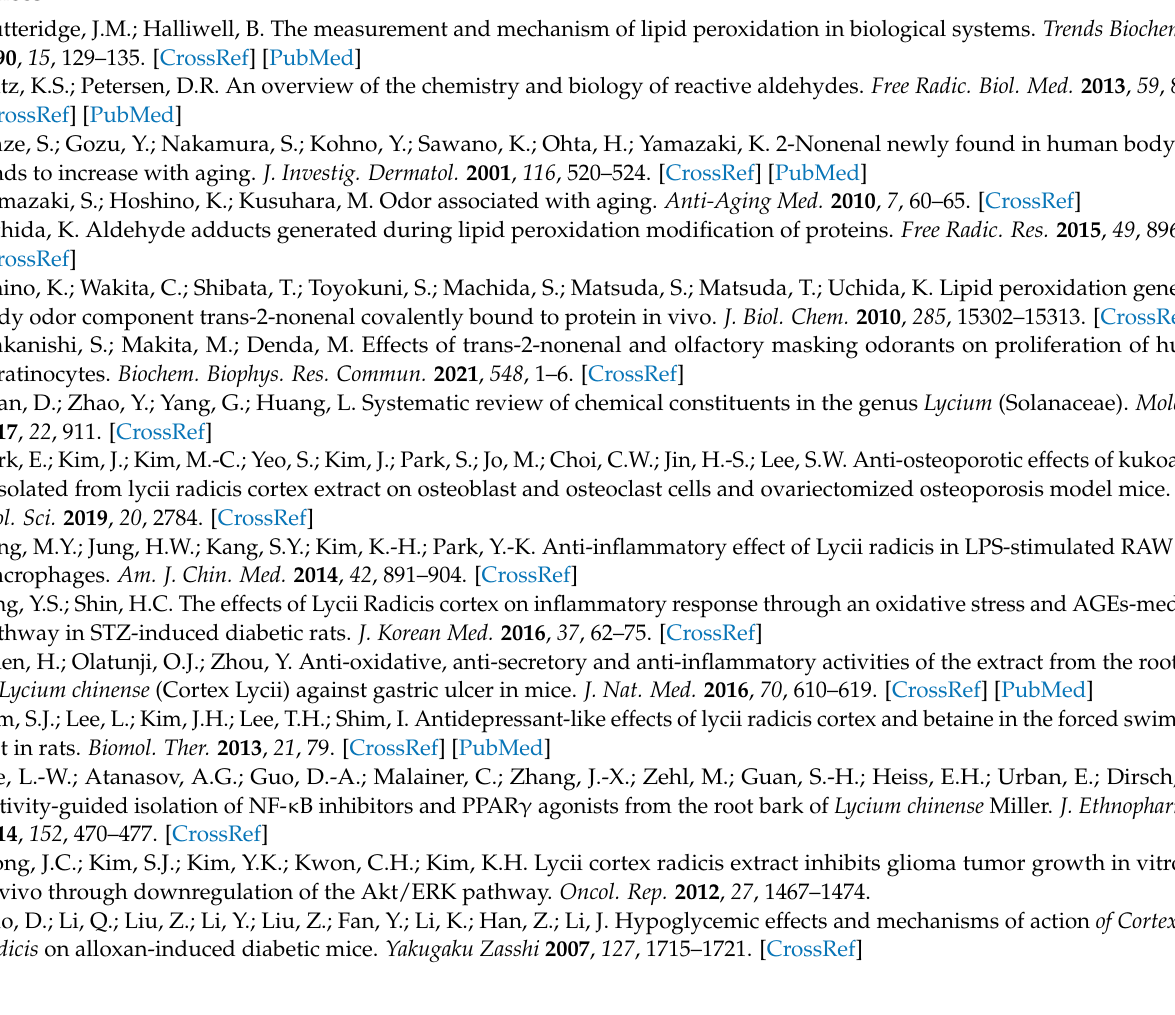
chromatogram of the LRC extract (10 mg/mL) dissolved in PBS; Figure S3: The HPLC chromatogram of LRC extract (100 mg/mL) after incubation with ( A ) 0.1 mM, ( B ) 50 mM, and ( C ) 100 mM of trans -2-nonenal for 24 h; Figure S4: The HPLC chromatogram of LRC extract (100 mg/mL) af- ter incubation with 100 mM of trans -2-nonenal for ( A ) 24 h, ( B ) 48 h, and ( C ) 72 h, respectively; Figure S5: Structures of the possible KB-modified adducts by trans -2-nonenal; Figure S6: Structures of the possible feruloylputrescine-modified adducts by trans -2-nonenal; Figure S7: LC-ESI-MS spectra of the ( A ) KB and ( B ) feruloylputrescine-modified adducts by trans -2-nonenal; Table S1: Calibration curves, detection limits, quantification limits, and recovery of the analyte (n = 5) by